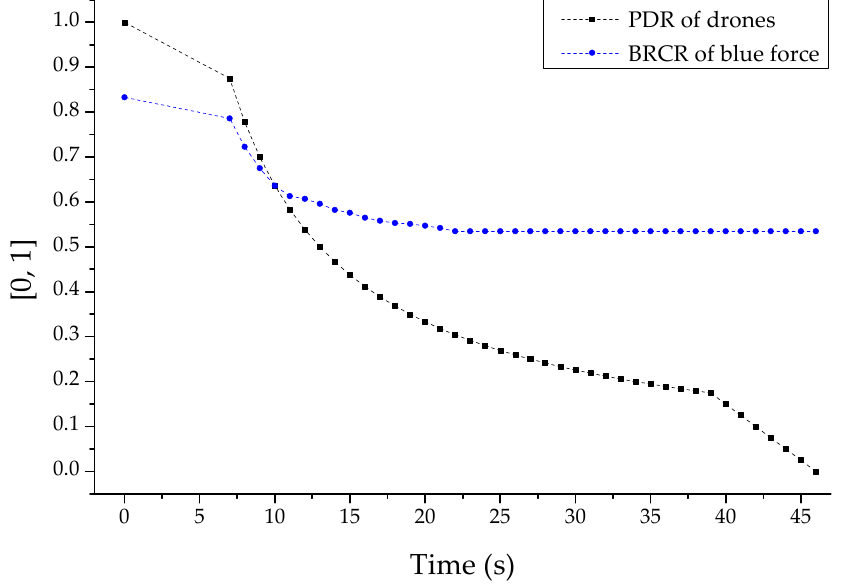
Figure 15. PDR (packet delivery ratio) and BRCR (blue remaining combat ratio)-based graph by reactive jammer-based multi-layered jammer attack.